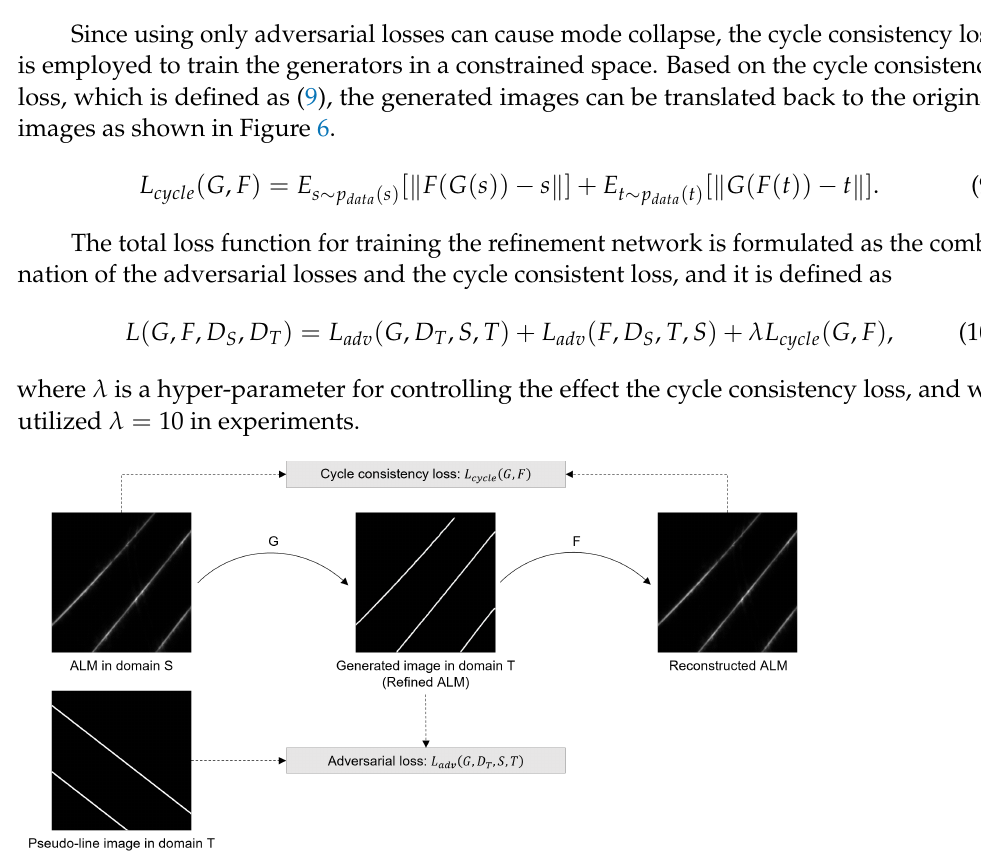
Figure 6. The process for generating refined ALMs. The generator G maps ALMs into the target domain, and therefore, responses of transmission lines are enhanced based on the line-shaped properties of the target domain